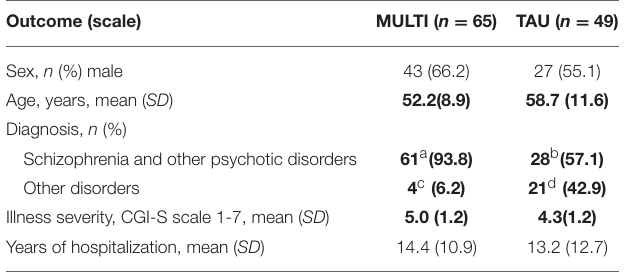
TABLE 1 | Baseline characteristics of patients ( N =